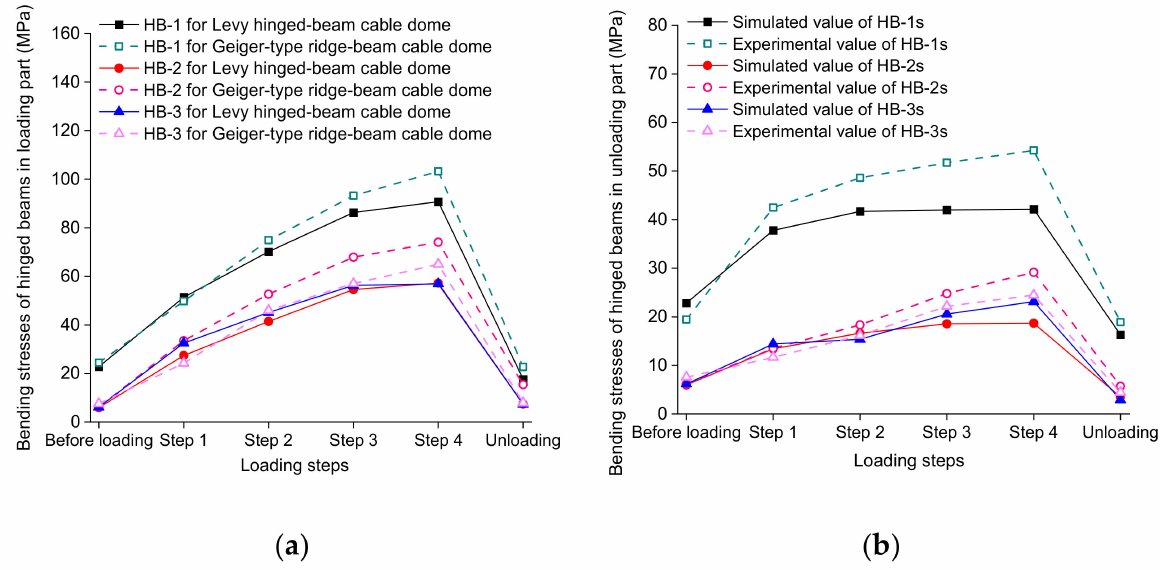
Figure 34. Comparative results of the bending stresses of the HBs. ( a ) Loading part; ( b ) Unloading part.